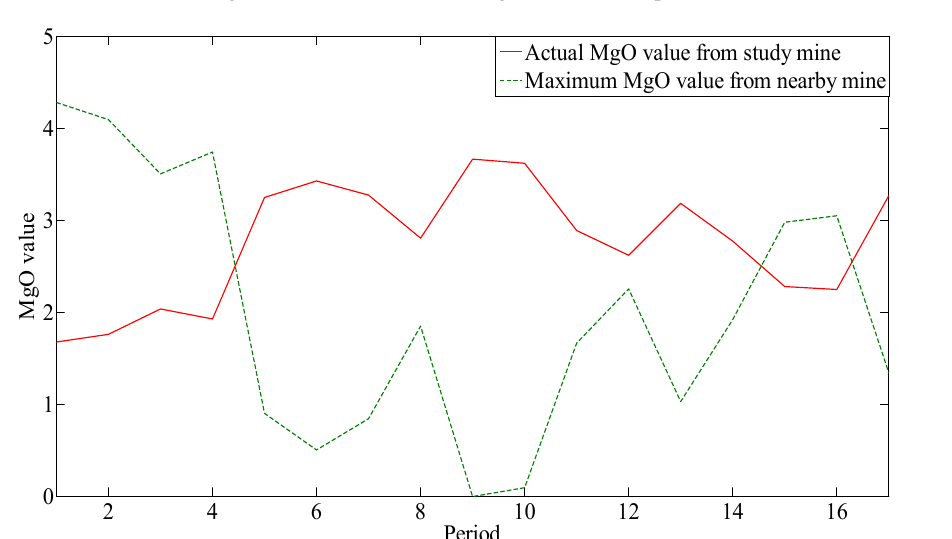
Figure 14. Model 2 MgO values from the study mine and a nearby mine for 17 periods.